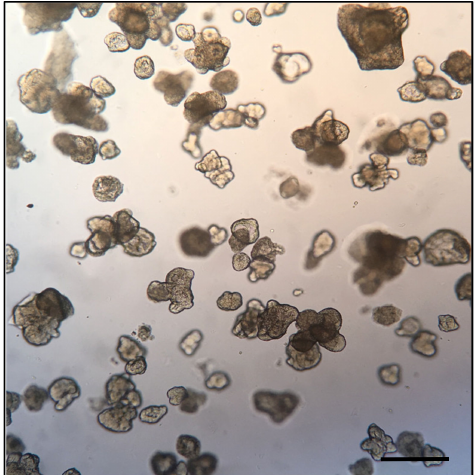
Figure 2. Bright field microphotograph depicting a representative field of human duodenum-derived enteroids in Matrigel. Each of the structures in the figure represents an enteroid at 8 days of culture, consisting of a 3D cellular aggregate organized into an epithelial monolayer resembling that of the small intestine. The apical surface of the monolayer faces the center of the enteroid while the basolateral surface faces the exterior. Bar scale indicates 1.0 mm; image from Stefania Senger, unpublished